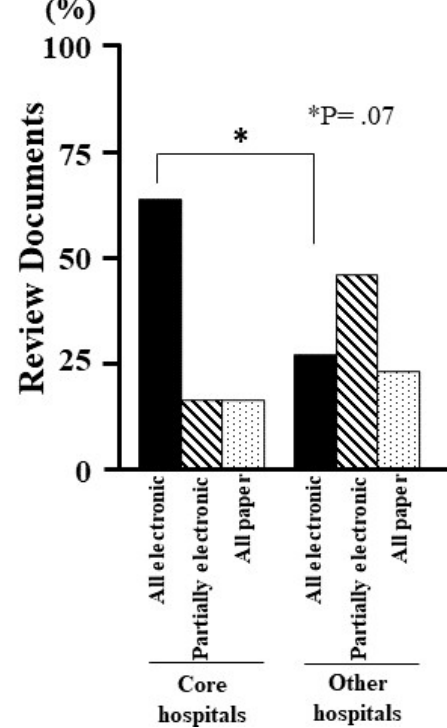
Figure 3. Digitization of review documents in Japanese university